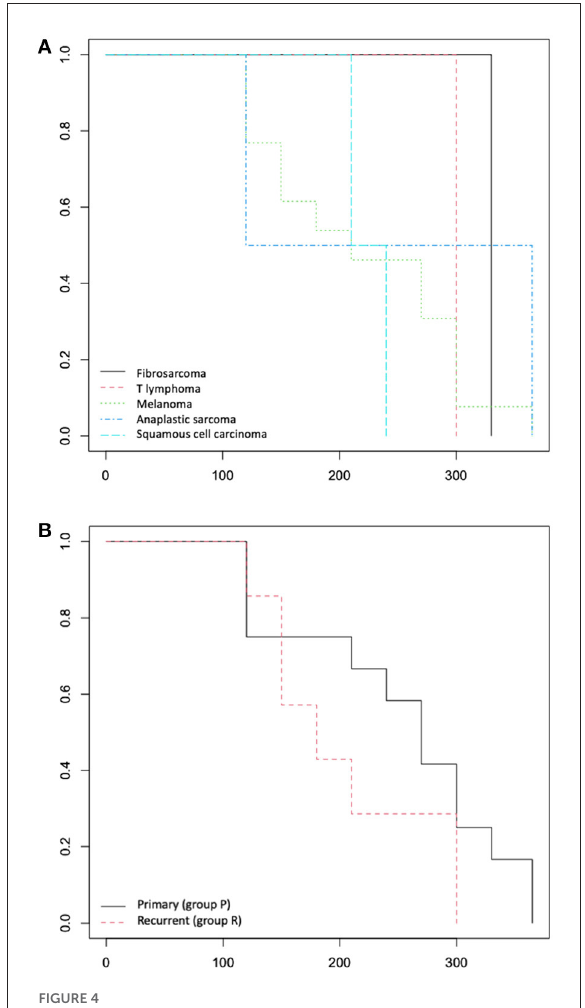
FIGURE4 (A) Overall survival time: Kaplan-Meier curve according to tumour histotype and (B) according to primary (group P) or recurrence (group R)